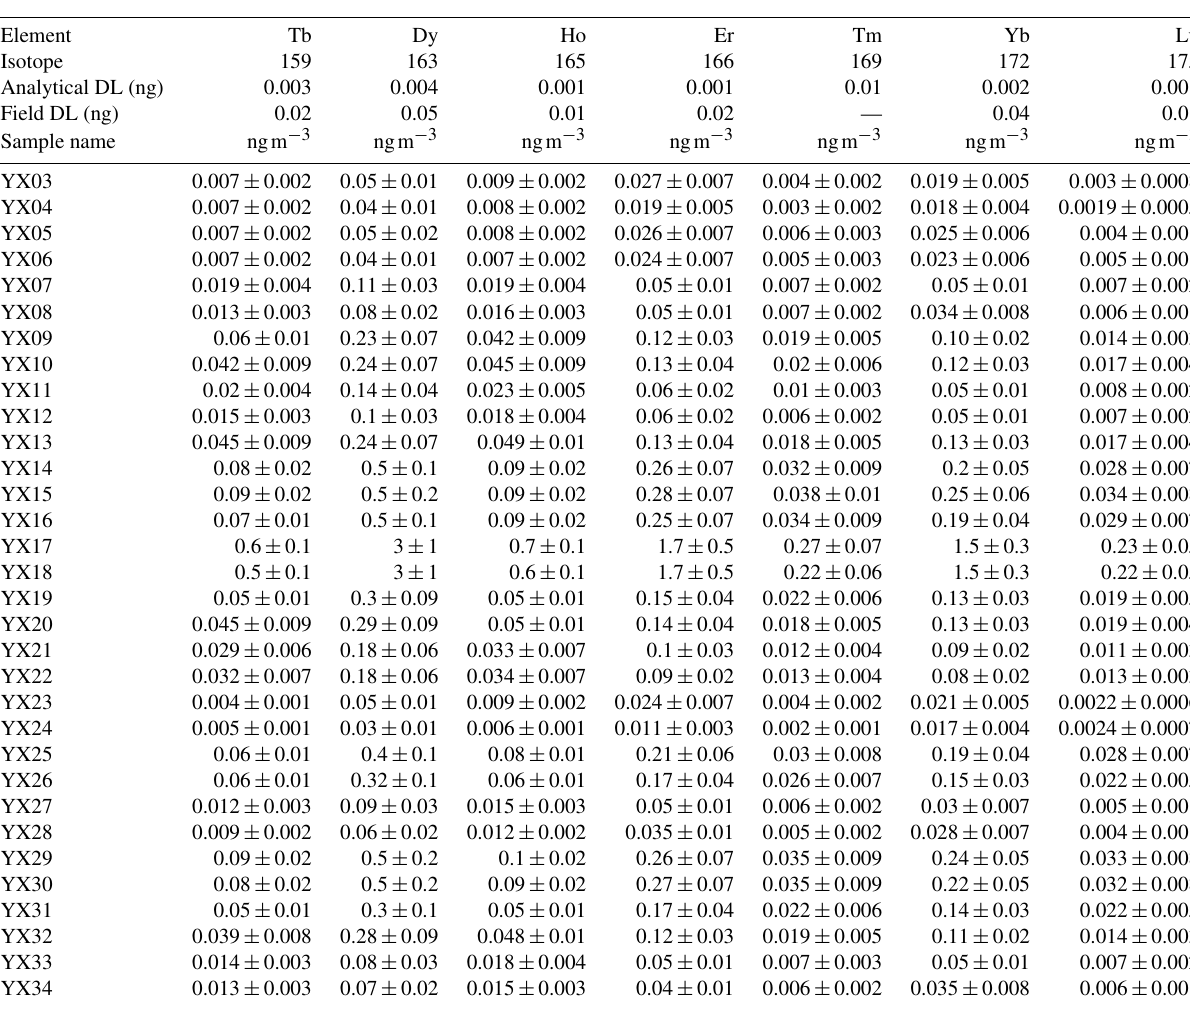
Table A7. REE air concentrations measured with ICP-MS,